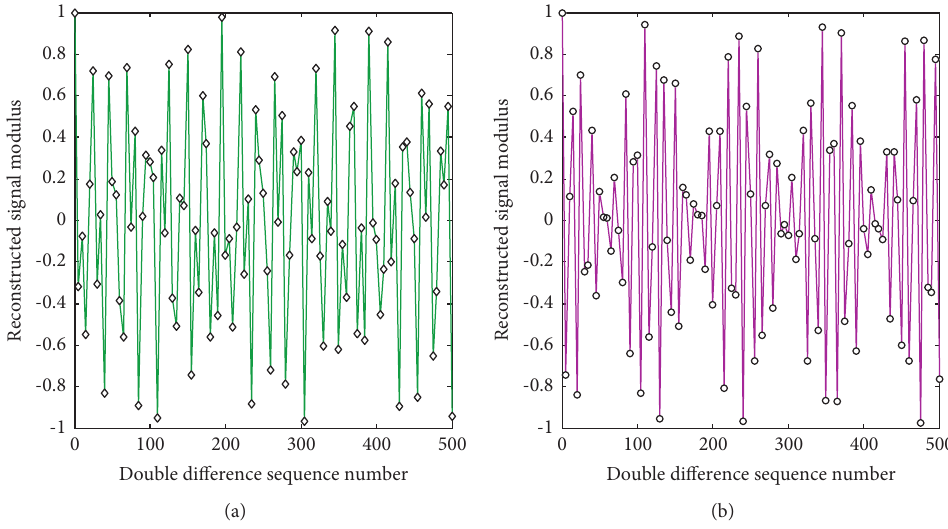
Figure 2: One-second sampling rate. (a) Detection without cycle slip; (b) detection with cycle